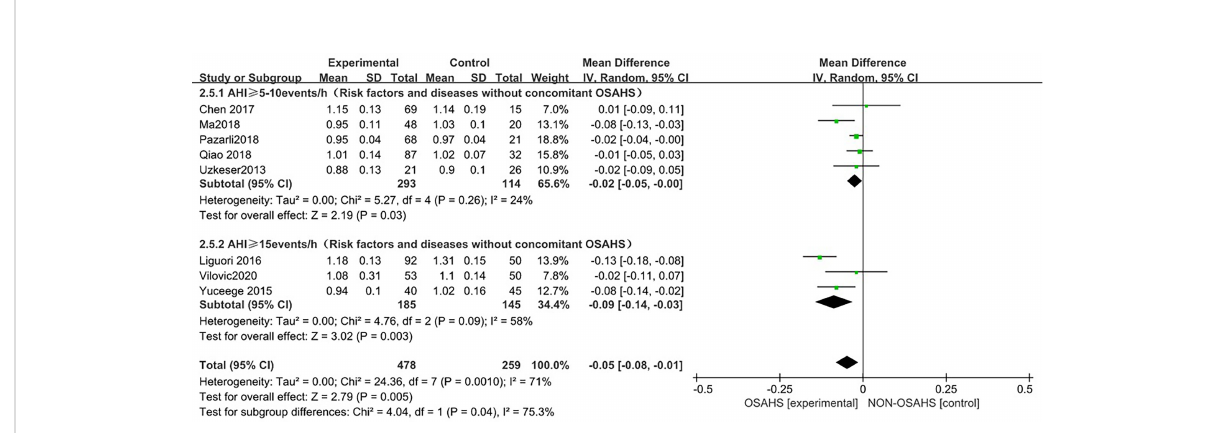
FIGURE 6 Forest plot of subgroup analysis of lumbar spine BMD in OSAHS group and control group by “ AHI group ” (grouped according to OSAHS diagnostic criteria, after exclusion of osteoporosis-related risk